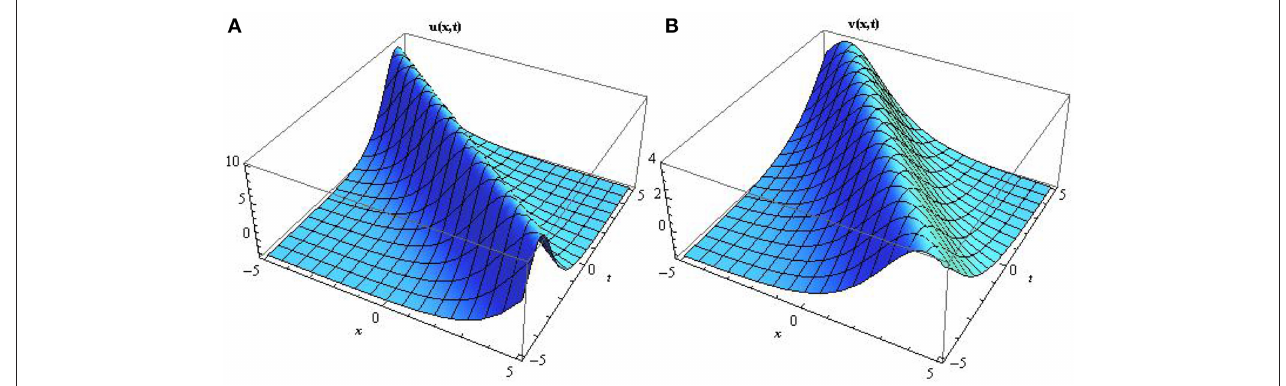
FIGURE 2 | Surface profile of the non topological soliton solutions A and B mathematically represented by Equation (33) describing several terminologies in the field of mathematical physics by setting a 1 = 0.5, b 2 = − 0.1, c 3 = 0.2, d = 2, e = 2, f =